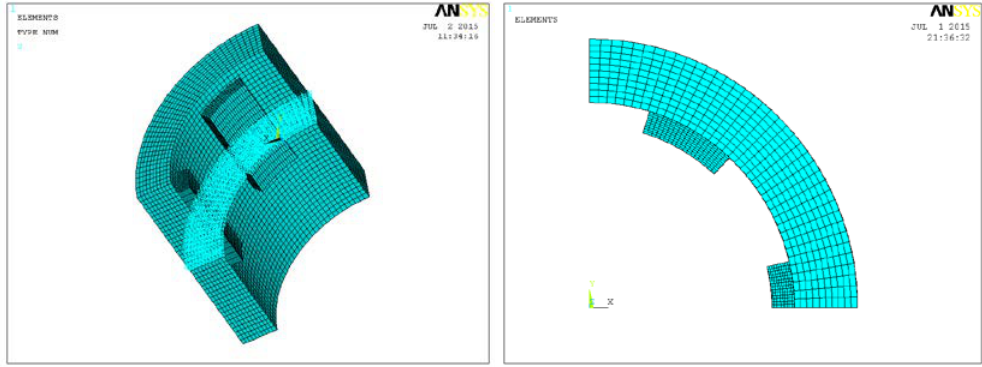
Figure 3: Numerical model and meshes of a hydraulic DTH hammer with horizontal oriented